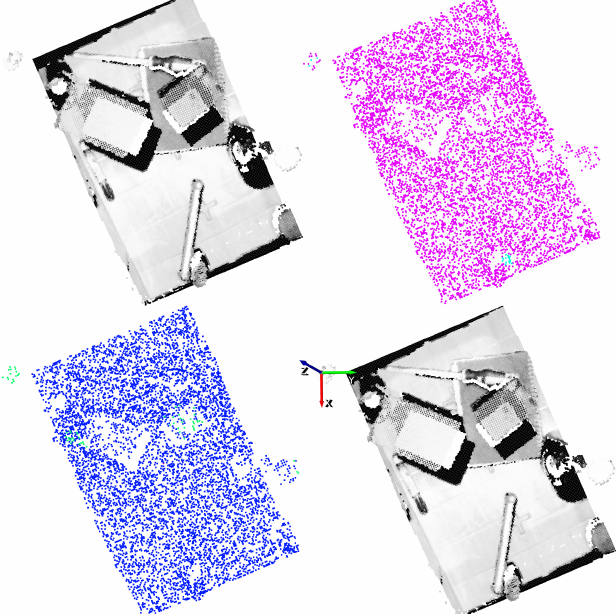
Figure 20. Gripper result example for n = 3. Top-left: point cloud of the scene. Top-right: ground- truth annotation. Bottom-left: top-1% predictions. Bottom-right: top-1 grasping point. The vertical orientation for the gripper is determined by the y (green)